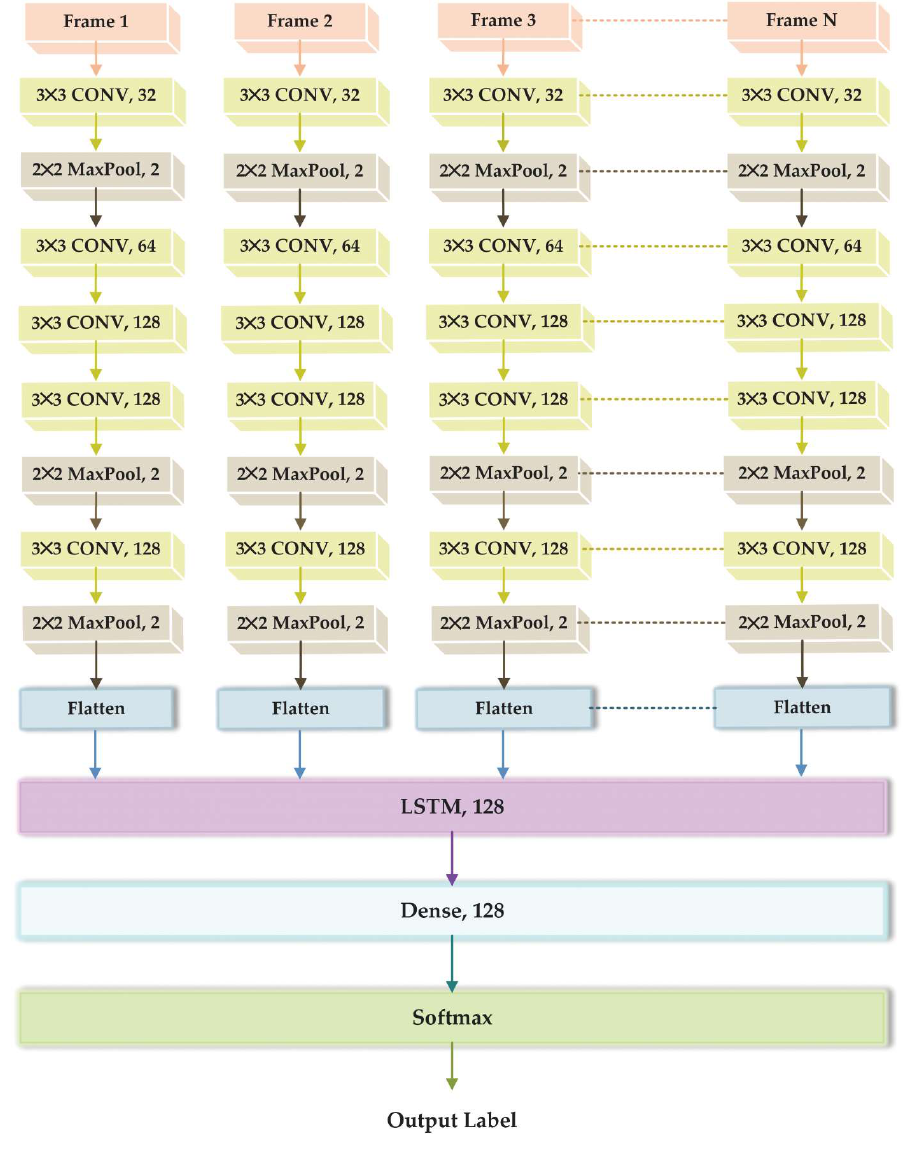
Figure 2. The architecture of the scratch